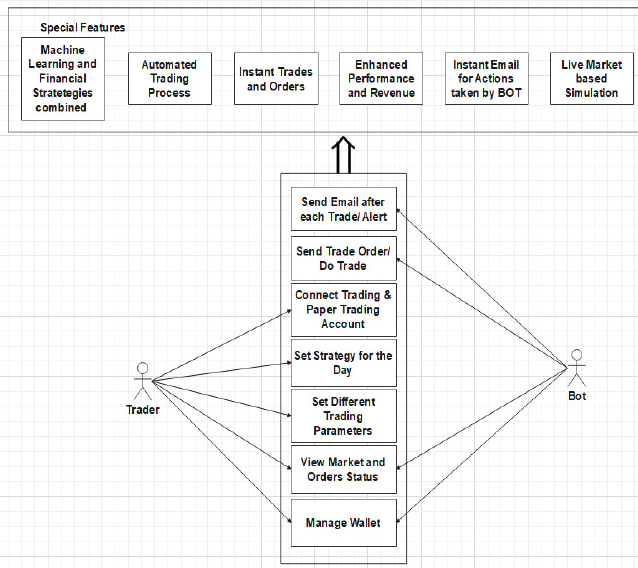
Figure 8 : Architectural Diagram for Algorithmic Trading